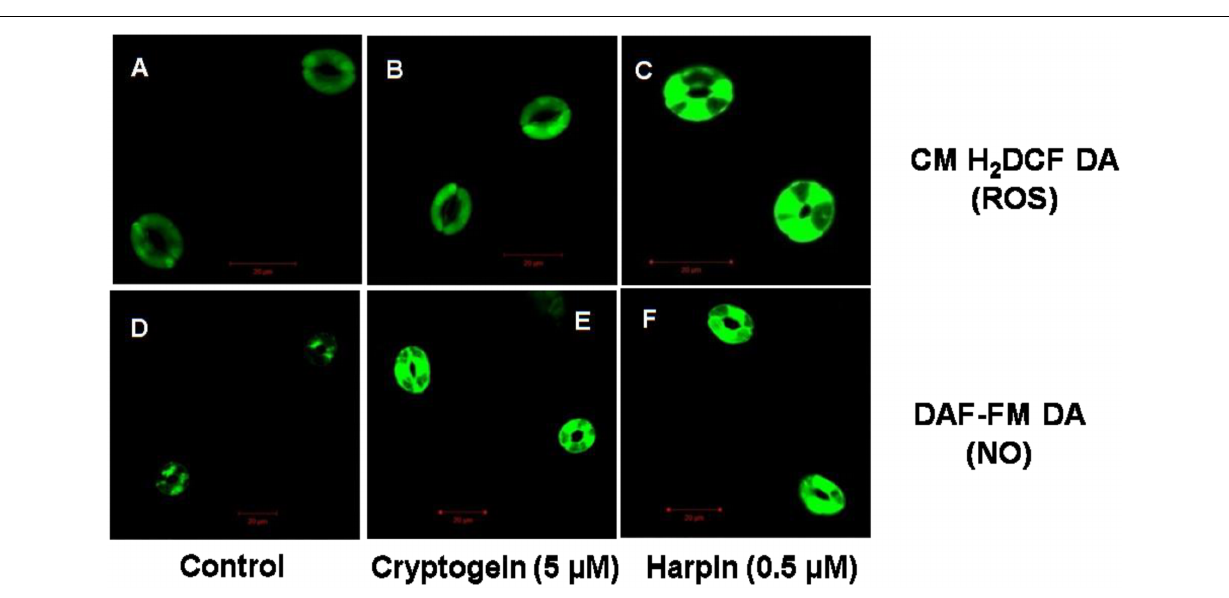
FIGURE 2 | Confocal images of ROS or NO levels in guard cells of A. thaliana , treated with cryptogein and harpin. The upper panel (A–C) represents the representative confocal images of the guard cells showing ROS levels indicated by CM-H 2 DCFDA fluorescent probe, in response to the microbial elicitors, cryptogein and harpin. The lower panel (D–F) represents the confocal images of the NO expressing guard cells by molecular probe DAF-FM DA, in response to the cryptogein and harpin. The levels of ROS or NO were more in the guard cells treated with the two microbial elicitors, were compared to guard cells which were untreated, i.e., control (A,D)